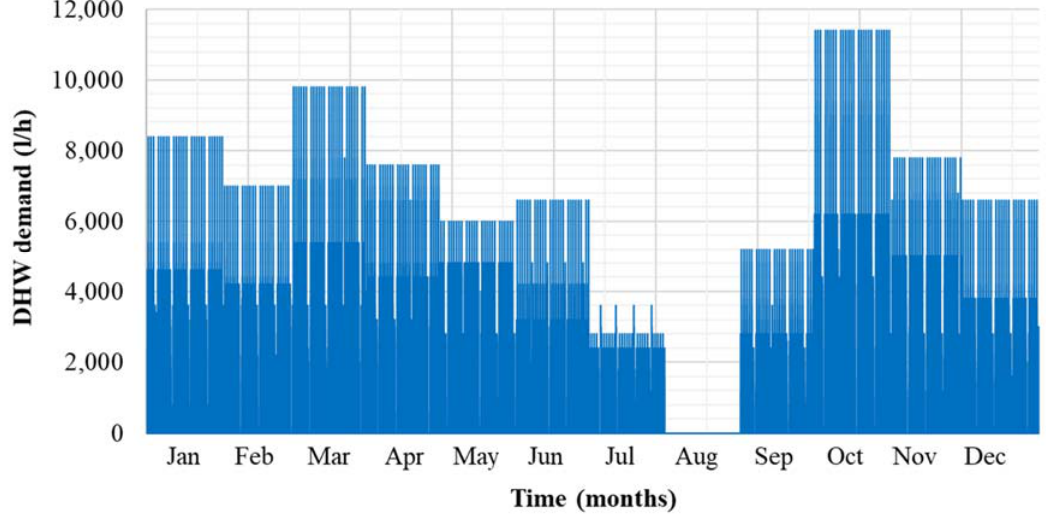
Figure 5. Domestic Hot Water (DHW) demand of the swimming pool users.